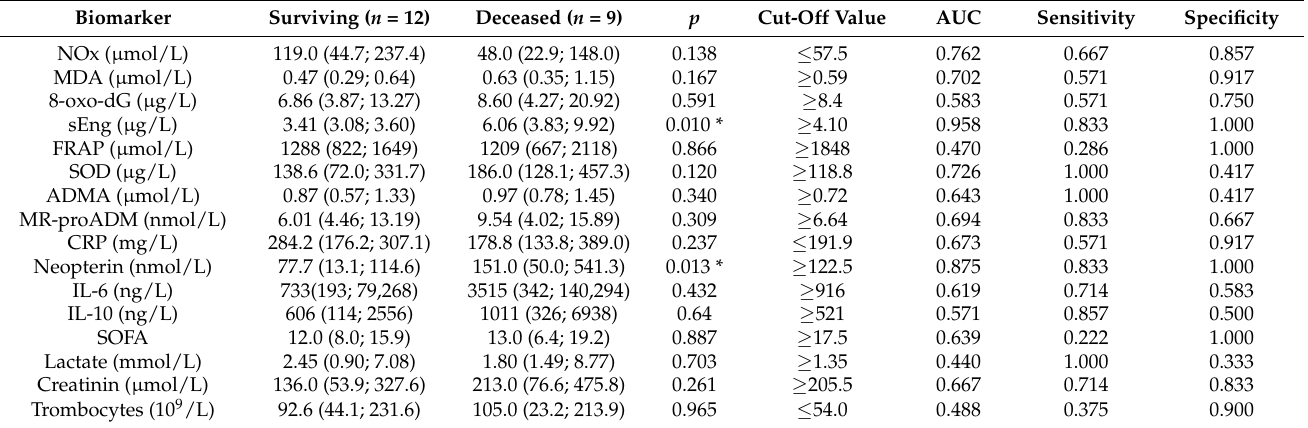
Table 3. Comparison of oxidative stress biomarkers’ values and clinical characteristics (12 h after admission—T2) in surviving and deceased patients and their ability to predict 3-month mortality according to